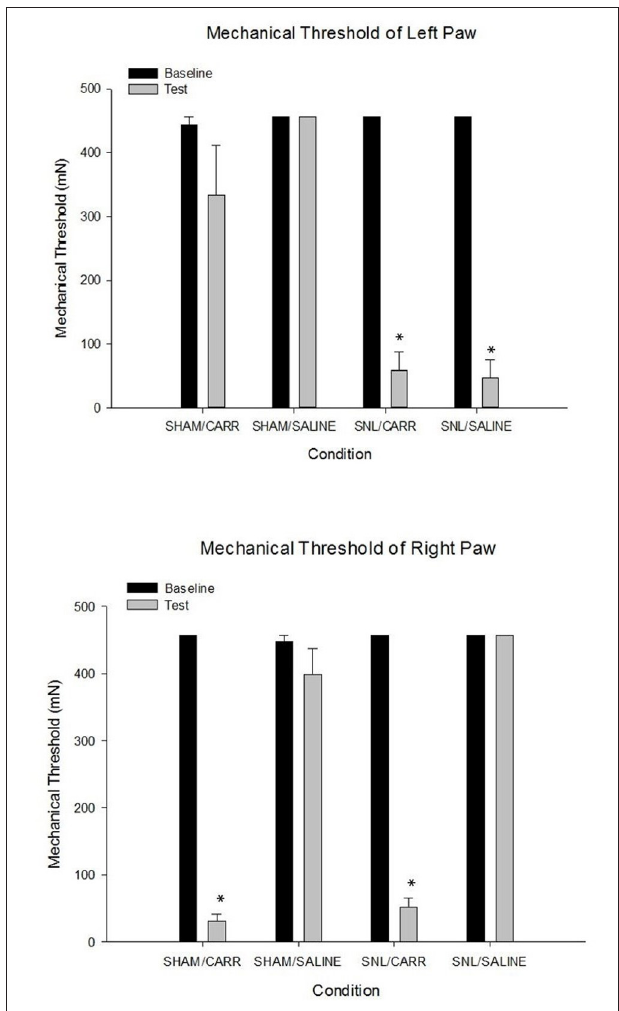
FIGURE 2 | Mechanical paw withdrawal threshold (MPWT) by pain conditions for both left and right paws for baseline and test days using mean ( ± SEM) MWPT score for each condition. The left paw was associated with L5 spinal nerve ligation (SNL) or sham condition. SNL conditions were associated with a significant decrease in withdrawal threshold for test days compared to sham animals. The right paw was associated with carrageenan or saline condition. Carrageenan-treated conditions were associated with a significant decrease in the withdrawal threshold for test days compared to saline animals. * p <